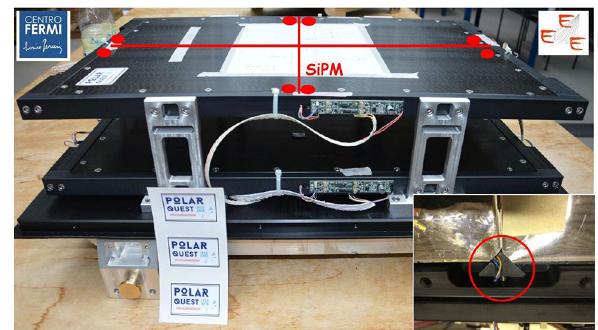
Fig. 1 One of the three PolarquEEEst detectors. The lines indicate the 4 tiles inside the internal light-tight box; the red points the position of the SiPMs. The small insert shows the cut on the scintillators (wrapped with mylar) and the wedge carved into the scintillators to ensure a good contact to the SiPM (red circle)